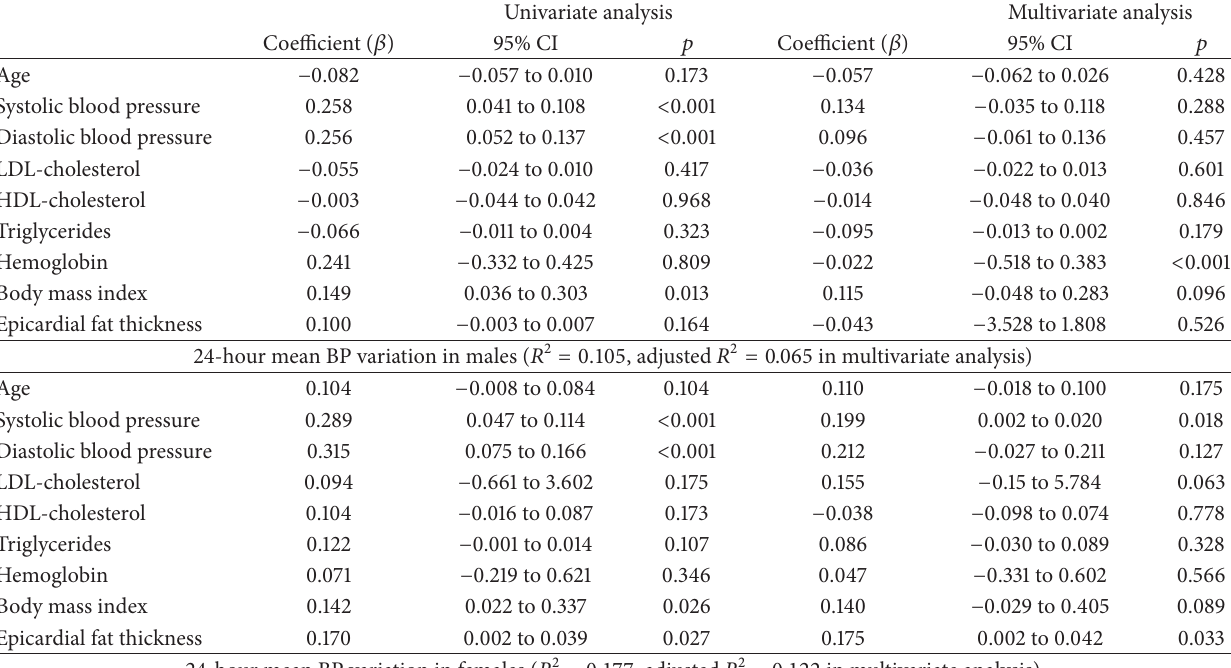
Table 7: Multiple linear regression analysis for the 24-hour mean BP variation in study groups according to the gender.